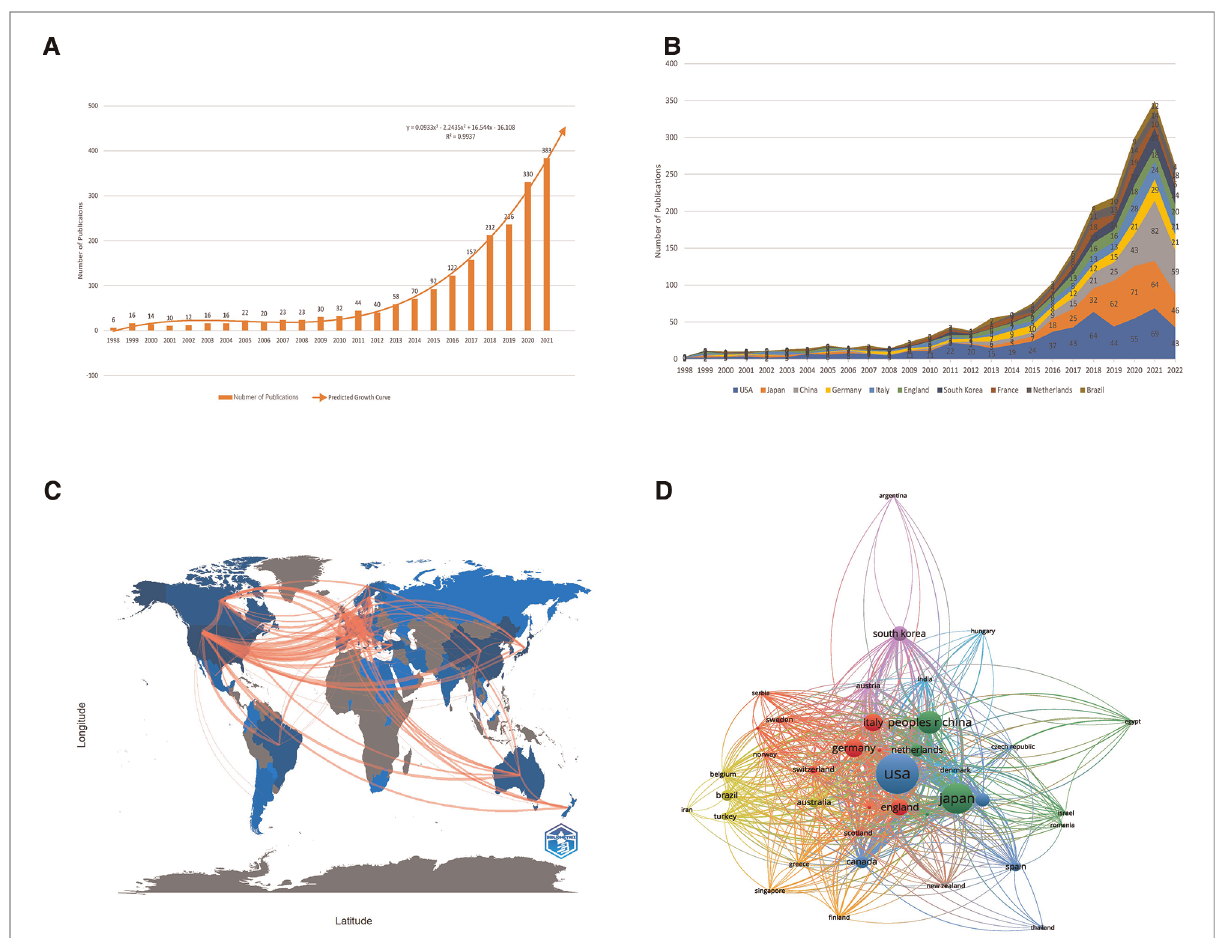
FIGURE 1 Analysis of general information and countries of publications. ( A ) The number of publications about the relationship between sarcopenia and surgery from 2000 to 2021; ( B ) The number of publications of the top 10 most productive countries from 200 to 2022; ( C ) Map of collaborative relationships between countries; ( D ) Map of citation relationships between countries. Different nodes present different countries. The size of nodes is proportional to the number of publications in each country, and the color of the lines between two nodes presents the relationship that the countries cited each other. The thicker the lines between two nodes, the higher the frequency with that they are cited to each